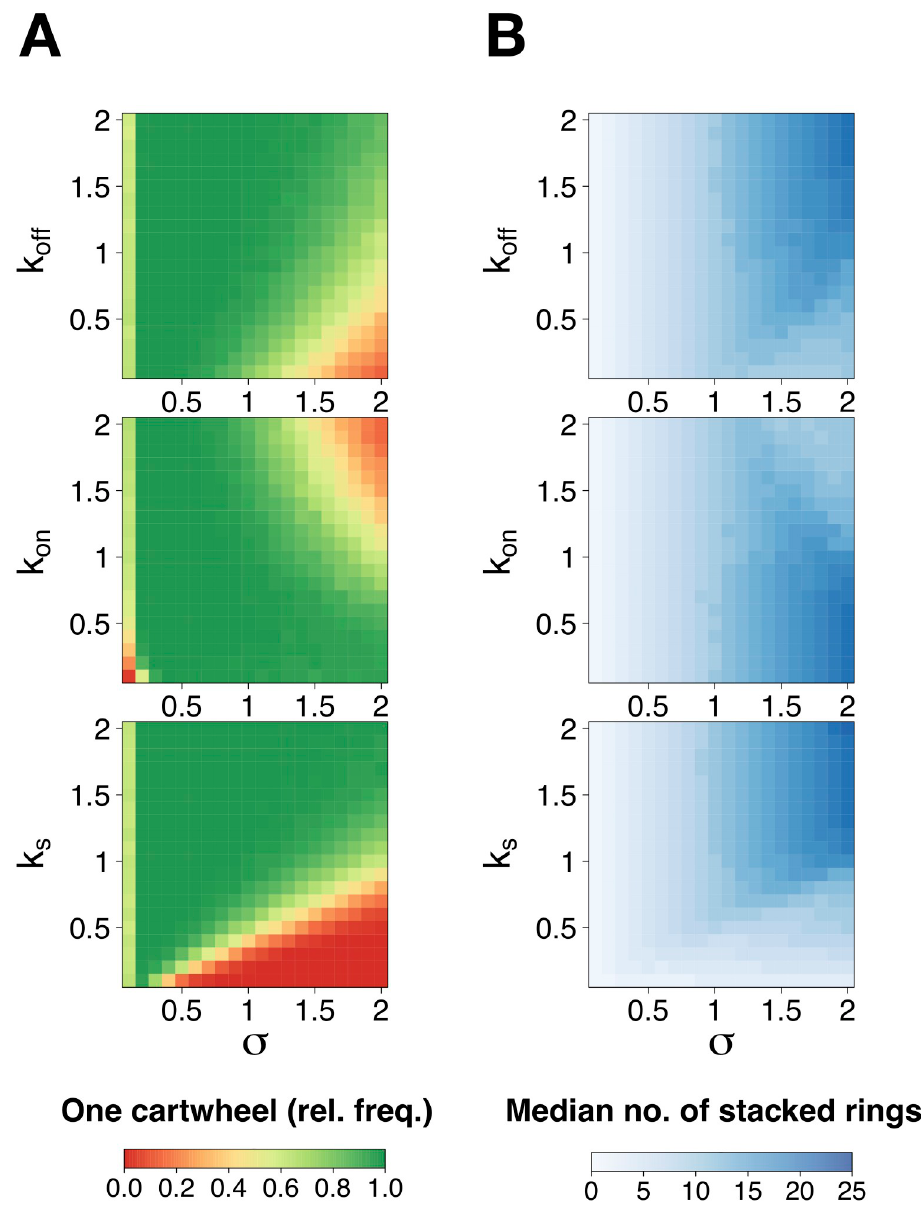
Fig 5. Probability of forming one and only one cartwheel as a function of influx and reaction parameters. Relative frequency of simulations containing a single cartwheel at time t = 100, under the model assuming irreversible ring assembly and stacking. We varied the indicated parameter values in steps of 0.1, yielding a total of 400 pairwise combinations of parameter values. We used default simulations conditions as indicated in Fig 3 and in the Models and methods